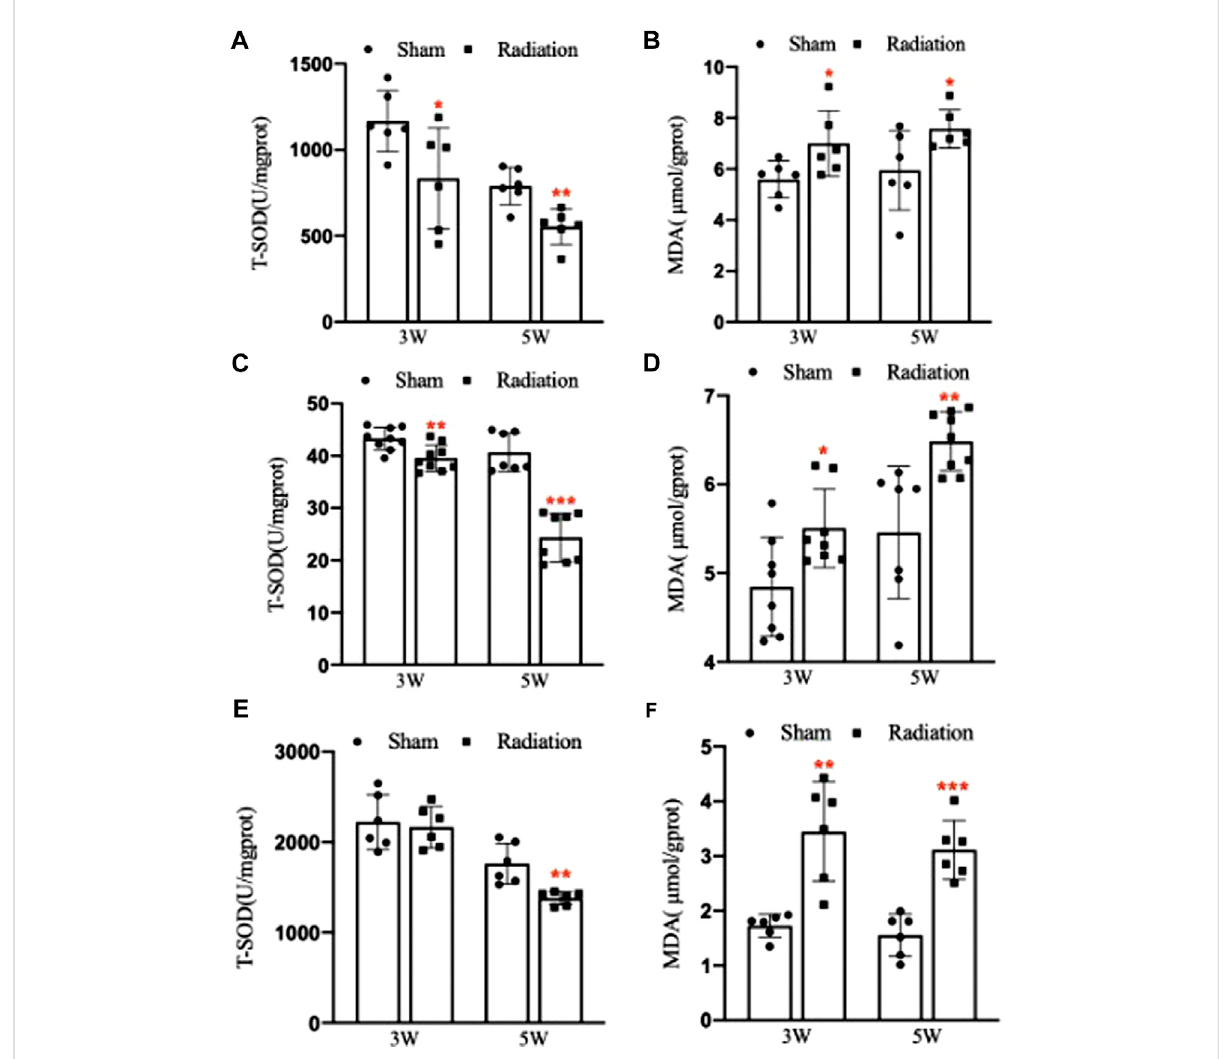
FIGURE 8 Abscopal effects of thoracic X-ray irradiation on oxidative stress levels in mice. (A) The concentration of T-SOD in lung of mice, n = 6 for each group. (B) The concentration of MDA in lung of mice, n = 6 for each group. (C) The concentration of T-SOD in serum of mice, n = 9 for each group. (D) The concentration of MDA in serum of mice, n = 9 for each group. (E) The concentration of T-SOD in testis of mice, n = 6 for each group. (F) The concentration of MDA in testis of mice, n = 6 for each group. The values are expressed as the mean ± SD, * p < 0.01; ** p < 0.01; *** p < 0.001 vs. sham